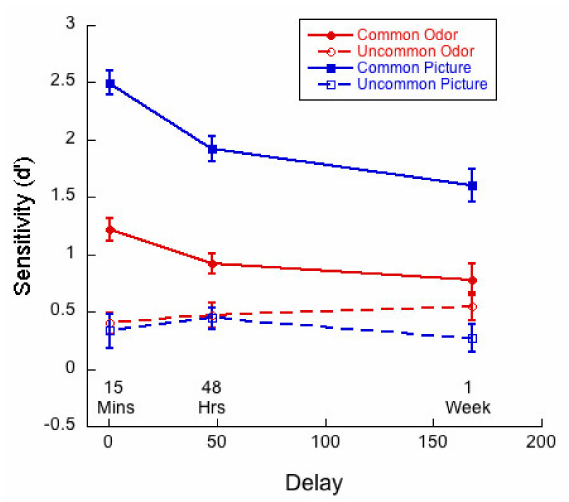
Figure 4. Sensitivity/d-prime (d’) as a function of delay for each of the four test conditions. There were 29 participants in the 15-min condition, 30 at 48 h and 27 at 1